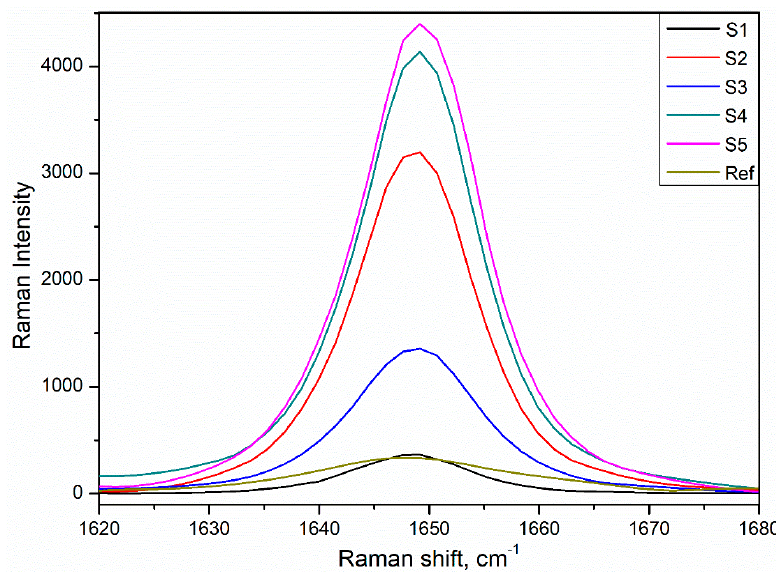
Figure 2. Raman spectra of Rhodamine 6G peak at ~1650 cm -1 measured on nanostructures and a pure glass substrate.